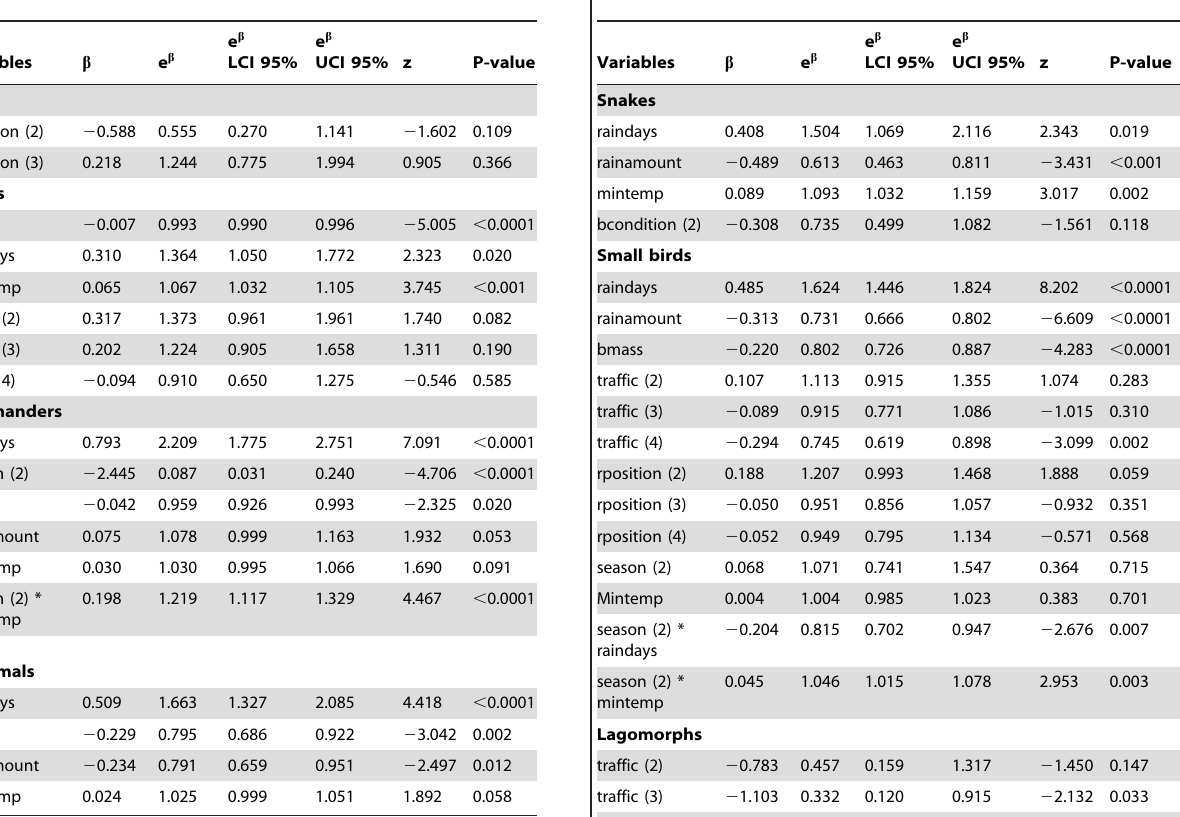
Table 5. Multivariate Cox hazards models for Snakes, Small birds, and Lagomorphs ( b : coefficients, e b : hazards ratio, e b LCI 95%: 95% lower confidence interval for hazards ratio, e b UCI 95%: 95% upper confidence interval for hazards ratio, z: Wald test, P-value: significance of Wald test, for variables definition, see table